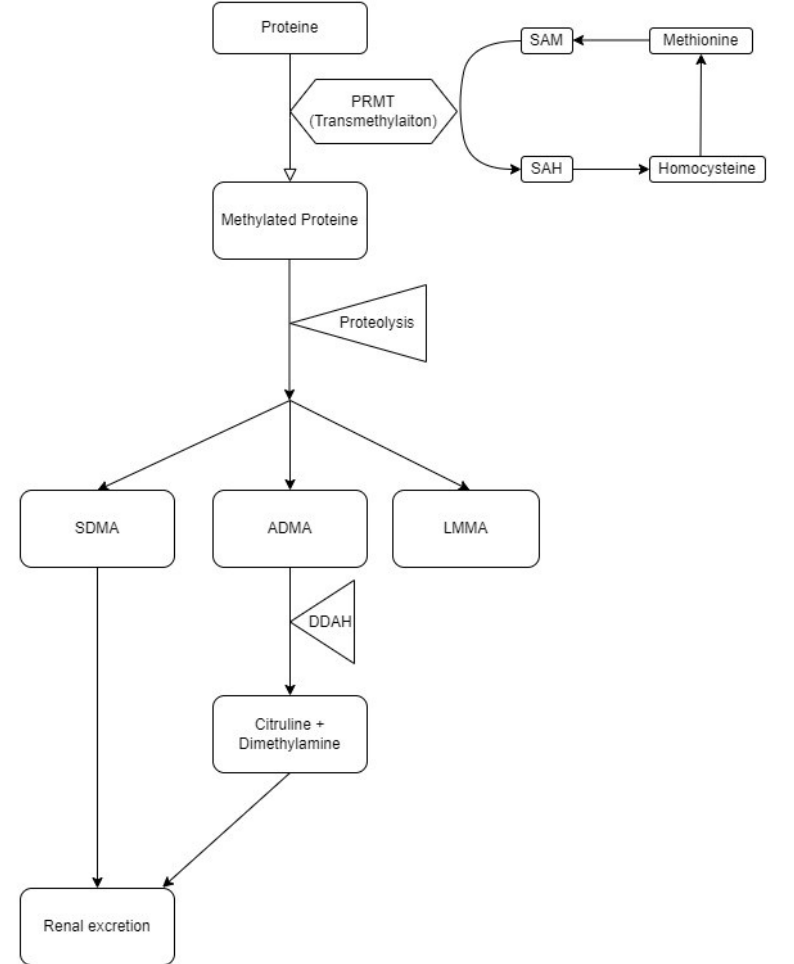
Figure 1. The diagram shows the metabolism of methylated arginine. PRMT protein arginine me- thyltransferases, SAM S-adenosylmethionine, SAH S-adenosylhomocysteine, SDMA symmetric di- methylarginine ADMA—asymmetric dimethylarginine, LMMA monomethyl-L-arginine, DDAH— Dimethylarginine dimethylaminohydrolase.